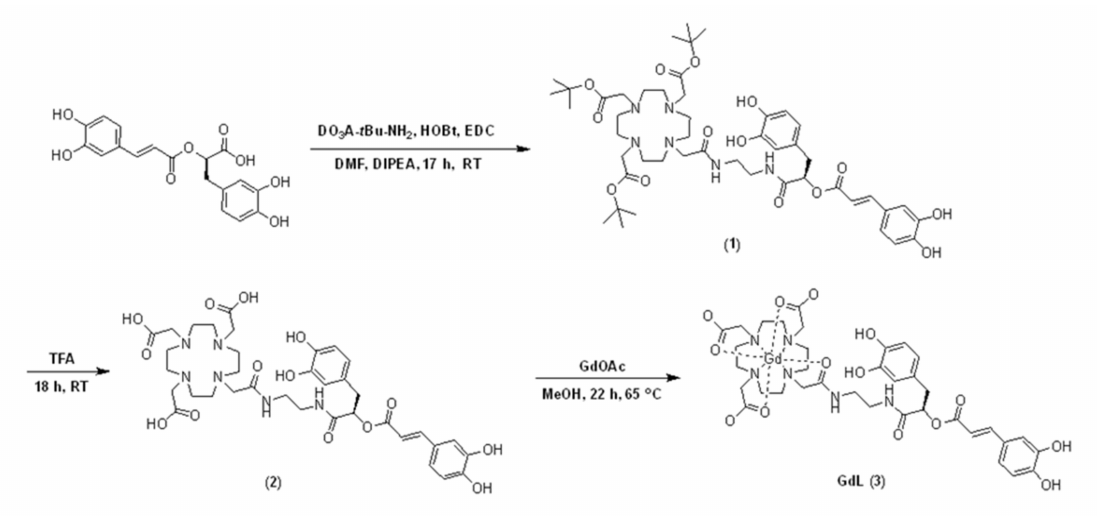
Figure 1. Synthesis of the gadolinium (Gd) complex of the DO3A-rosmarinic acid conjugate.